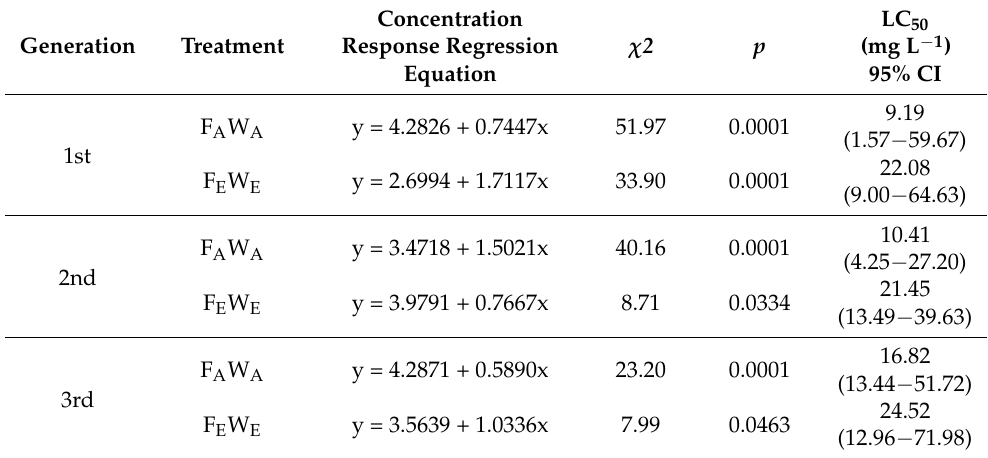
Table 1. Toxicity effect of chlorantraniliprole on 4th larvae of the FAW under eCO 2 and aCO 2 . Concentration Generation Treatment Response Regression